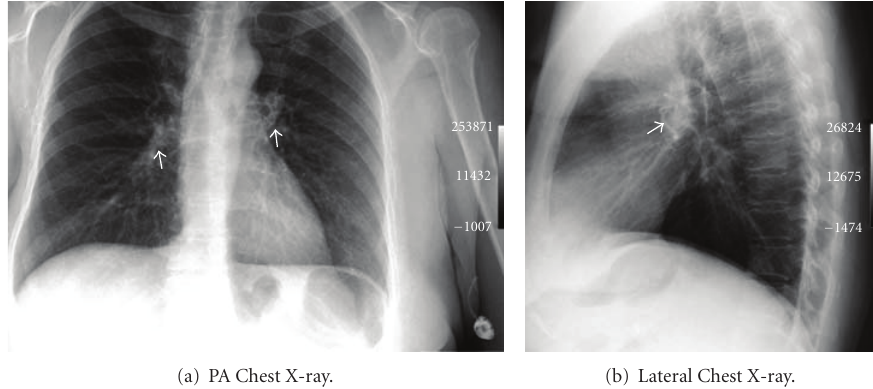
Figure 1: (a) The PA chest X-ray demonstrates the catheter fragment superimposed upon the mediastinum with portions of the catheter seen in both hilar regions (arrows). The arm port and the residual catheter are seen in the arm, cranial to the antecubital fossa, on the margin of the image. (b) The lateral chest X-ray demonstrates the catheter fragment superimposed upon the mediastinum (arrow).